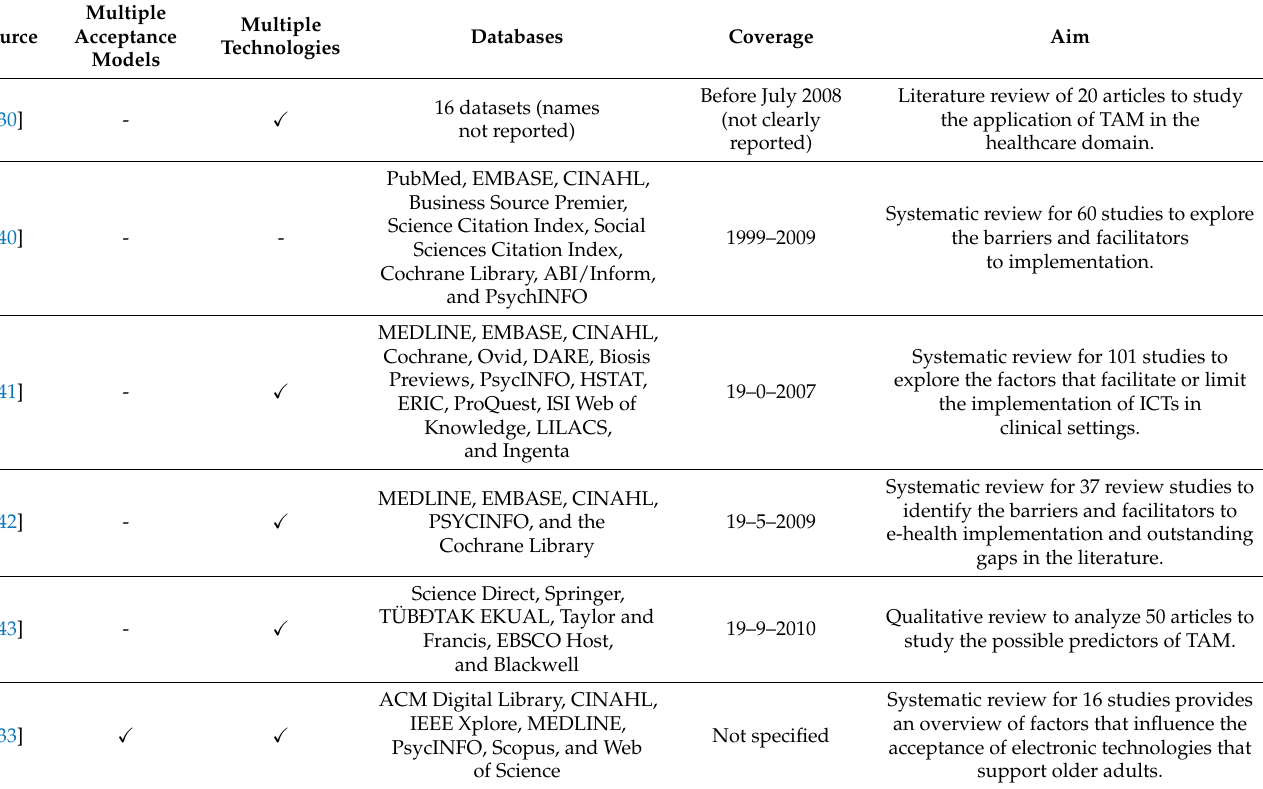
Table 1. Previous review studies on technology acceptance in